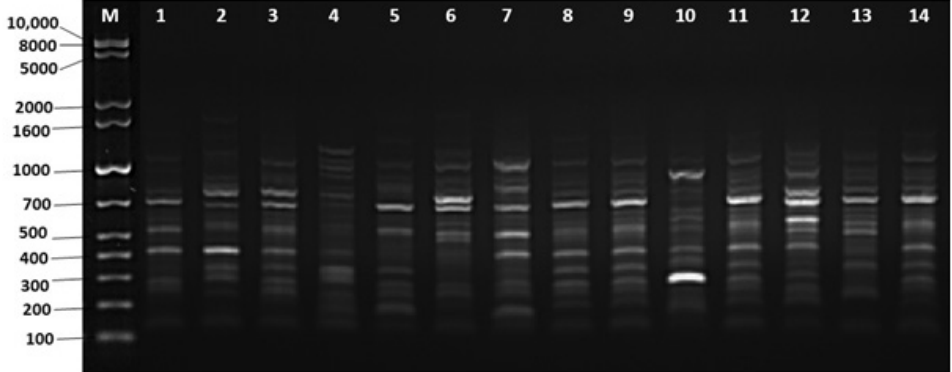
Fig. 3. Amplified DNA fingerprints generated by ERIC-PCR using ERIC1R primer. Lane M: 1kb plus ladder; lane 1 to 14: representative isolates of V. vulnificus isolated in this